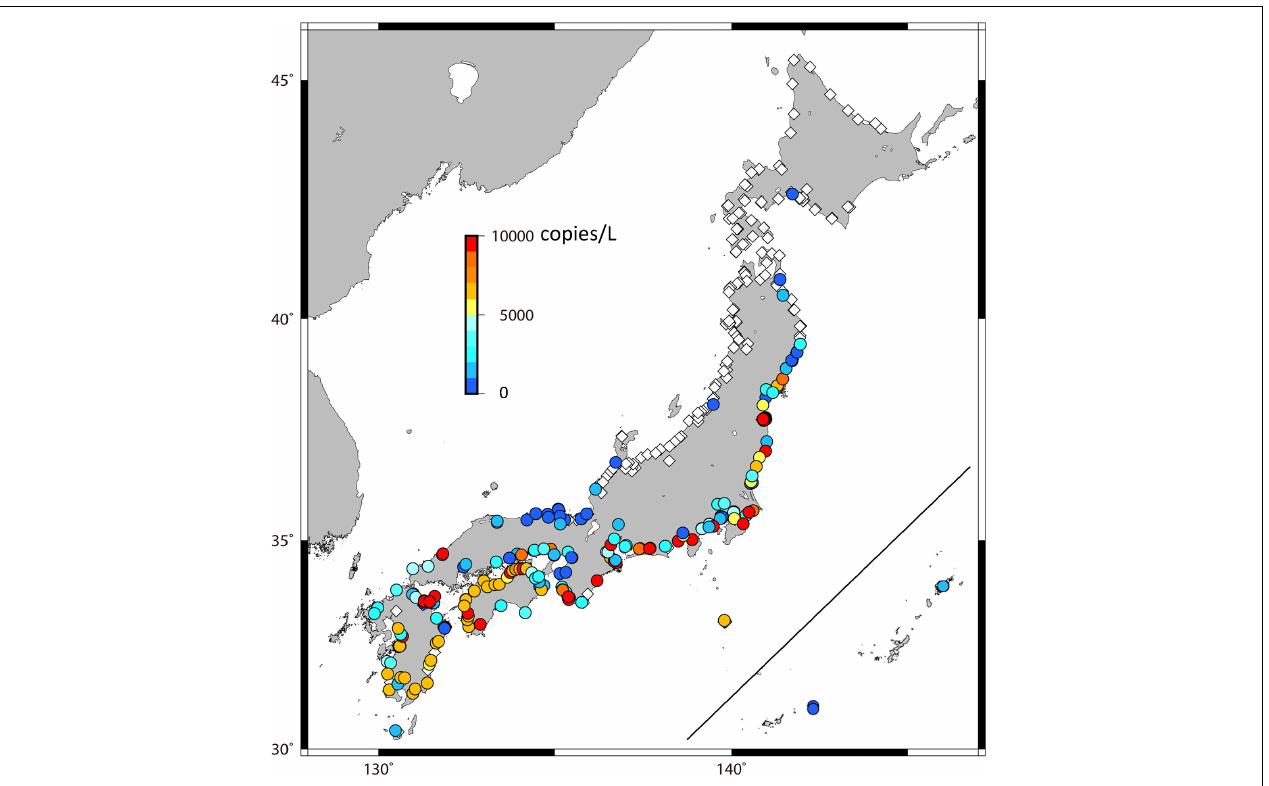
FIGURE 2 | Concentration of environmental DNA at each observation point. Warmer and colder colors represent larger and smaller values, respectively, and dark red points represent more than 10,000 copies/L. Open diamonds indicate zero.